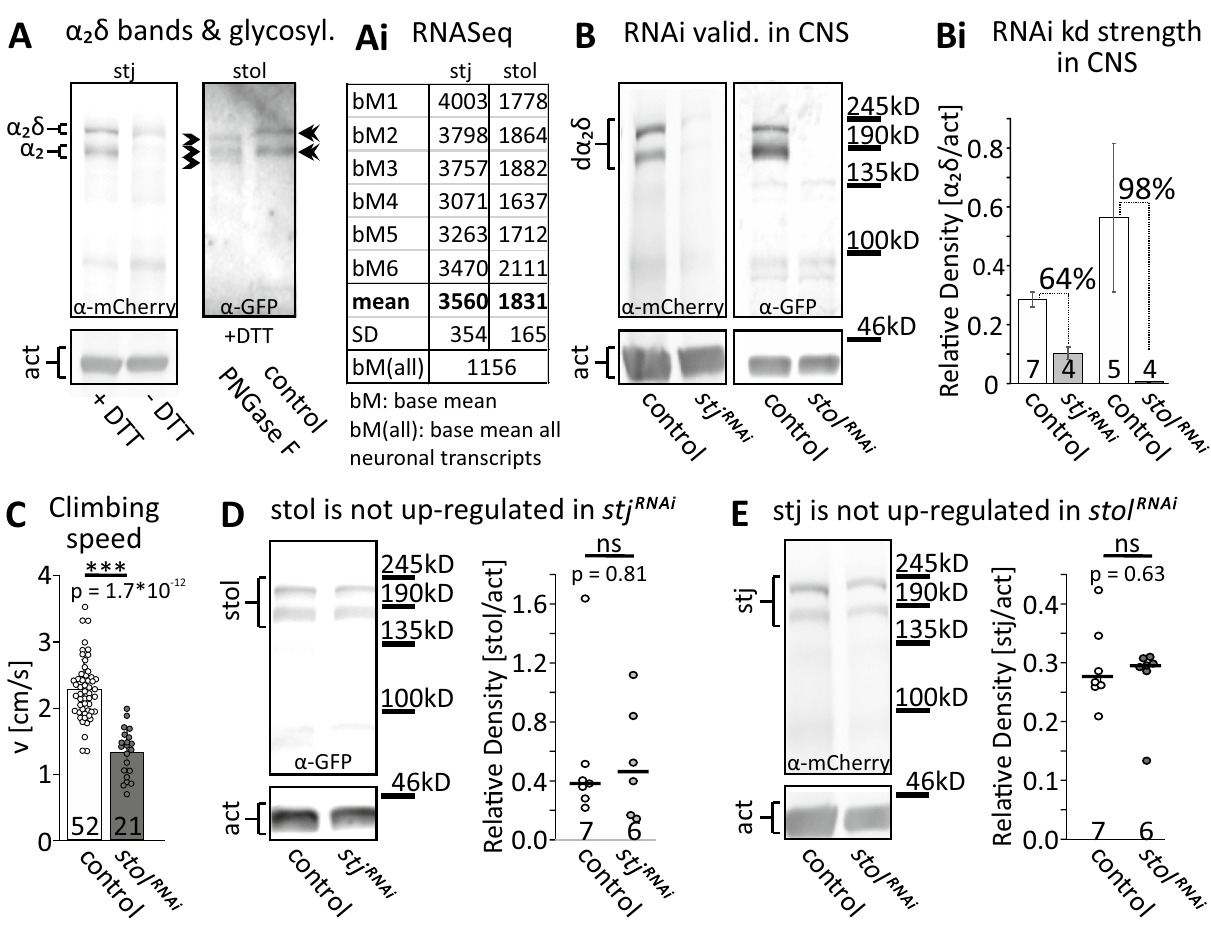
Figure 1. Neuronally expressed stj and stol can effectively be knocked down by RNAi. (A) Western blots of endogenous stj mCherry (left) and stol GFP (right) show two bands in the presence of the reducing agent dithiotreitol (DTT) that cleaves disulfide bonds. The tags reside close to the N-terminus on the α 2 moiety. The upper bands correspond in size to un-cleaved α 2 δ and the lower bands to cleaved α 2 with mCherry (stj) or GFP-tag (stol), respectively. Without DTT only the larger band at the size of un-cleaved stj mCherry is present (A, left blot, right lane). PNGase F de-glycosylation ( A , right blot, left lane) of purified stol GFP (pulled-down) reduces upper band size by ~ 20 kDa, whereas the lower band splits into two bands, one unchanged and one ~ 20 kDa lower (see arrowheads). (Ai) Base mean (bM) expression levels of stj (left) and stolid (right) mRNA as observed by RNAseq from Drosophila brain with 6 biological replicates each (upper 6 rows). Mean and SD are in rows 7 and 8. Mean expression levels of stj and stol are higher than the mean of all genes expressed in brain (row 9). (B, Bi) Western blotting (B) shows effective knock-down of stj mcherry (left) and of stol GFP (right) by pan-neural RNAi ( elav c155 - GAL4 > UAS-RNAi; UAS-dcr2 ). (Bi) Quantification reveals 64% knock-down efficacy for stj RNAi (control and knock-down, left two bars), and 98% for stol RNAi (right two bars). Numbers of replicates are indicated in each bar. (C) In a negative geotaxis assay, pan-neural stol RNAi results in a 40% reduction of median climbing speed from 2.3 to 1.4 cm/s as compared to control (N for control: 52, for stol RNAi : 21; *** p < 0.001, Mann–Whitney U test). (D) Western blot of stol GFP in control (left lane) and with pan-neural stj RNAi (right lane). Quantification shows that pan-neural stj RNAi does not affect stol protein level ( p = 0.81, Mann–Whitney U test). (E) Western blot of stj mCherry in control (left lane) and with pan-neural stol RNAi (right lane). Quantification shows that stol RNAi does not affect stj protein level ( p = 0.63, Mann–Whitney U test). Data in (D) and (E) are presented as single data points with